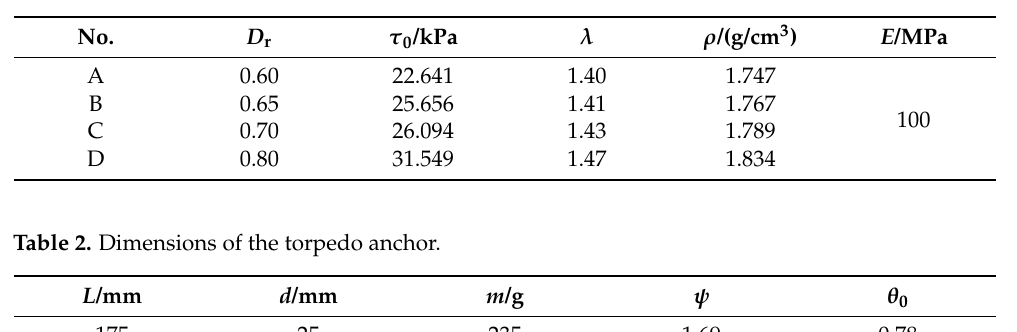
Table 1. Strength parameters of saturated sand.